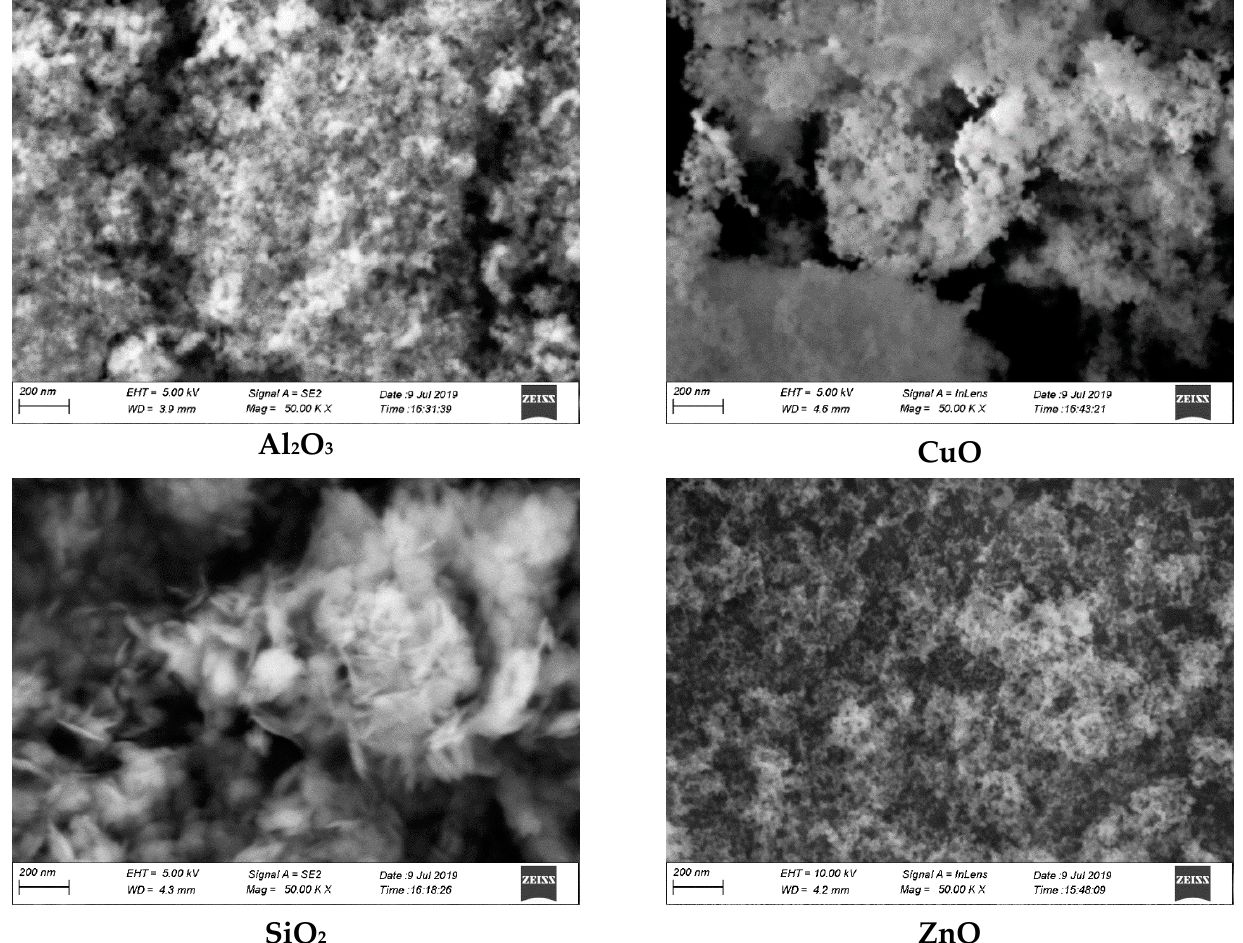
Figure 4. FE-SEM images of different metal oxides nanostructures at the nanoscale of 200 nm.